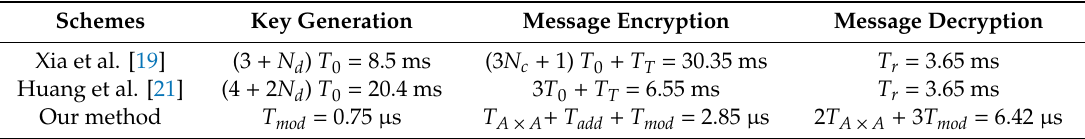
Table 5. Computation